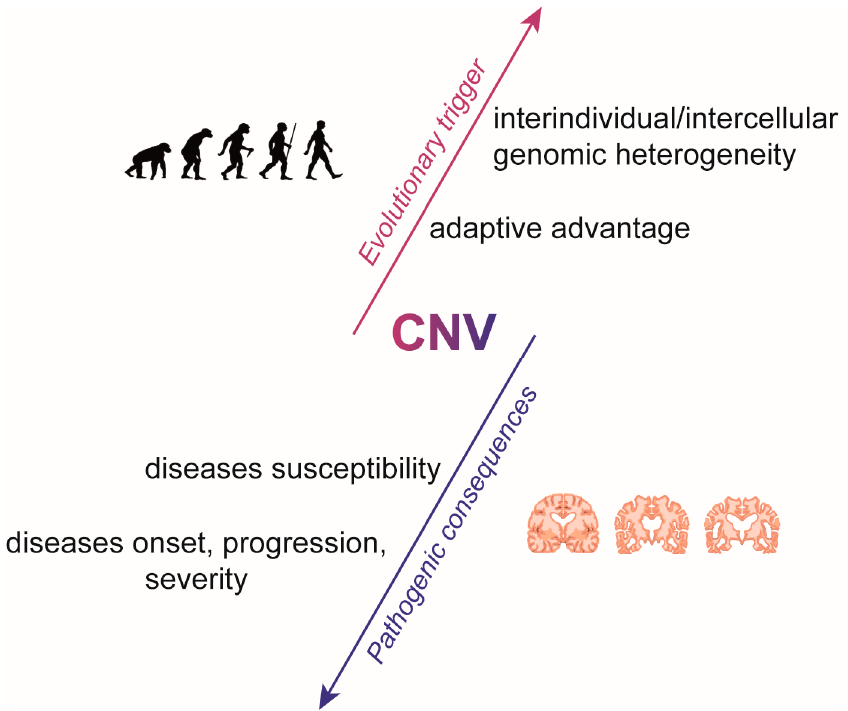
Figure 2. Opposite roles of CNVs: Evolution and Disease. CNVs could contribute to evolutionary trigger mechanisms as well as to the susceptibility and pathogenesis of several diseases.